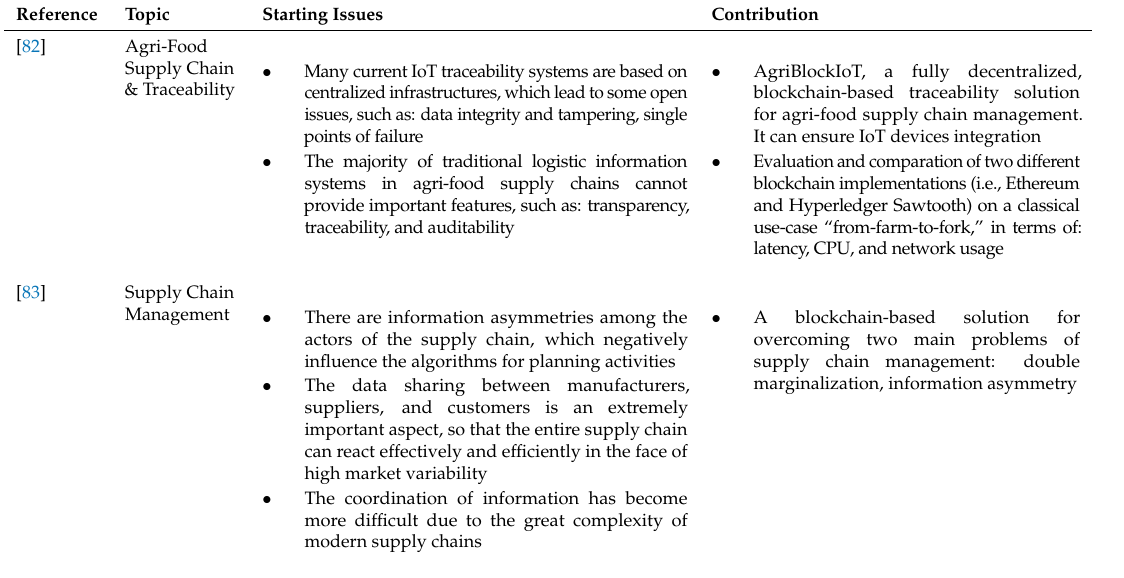
Table 7. Analysis of the most relevant documents belonging to C 1 (part 3/3).